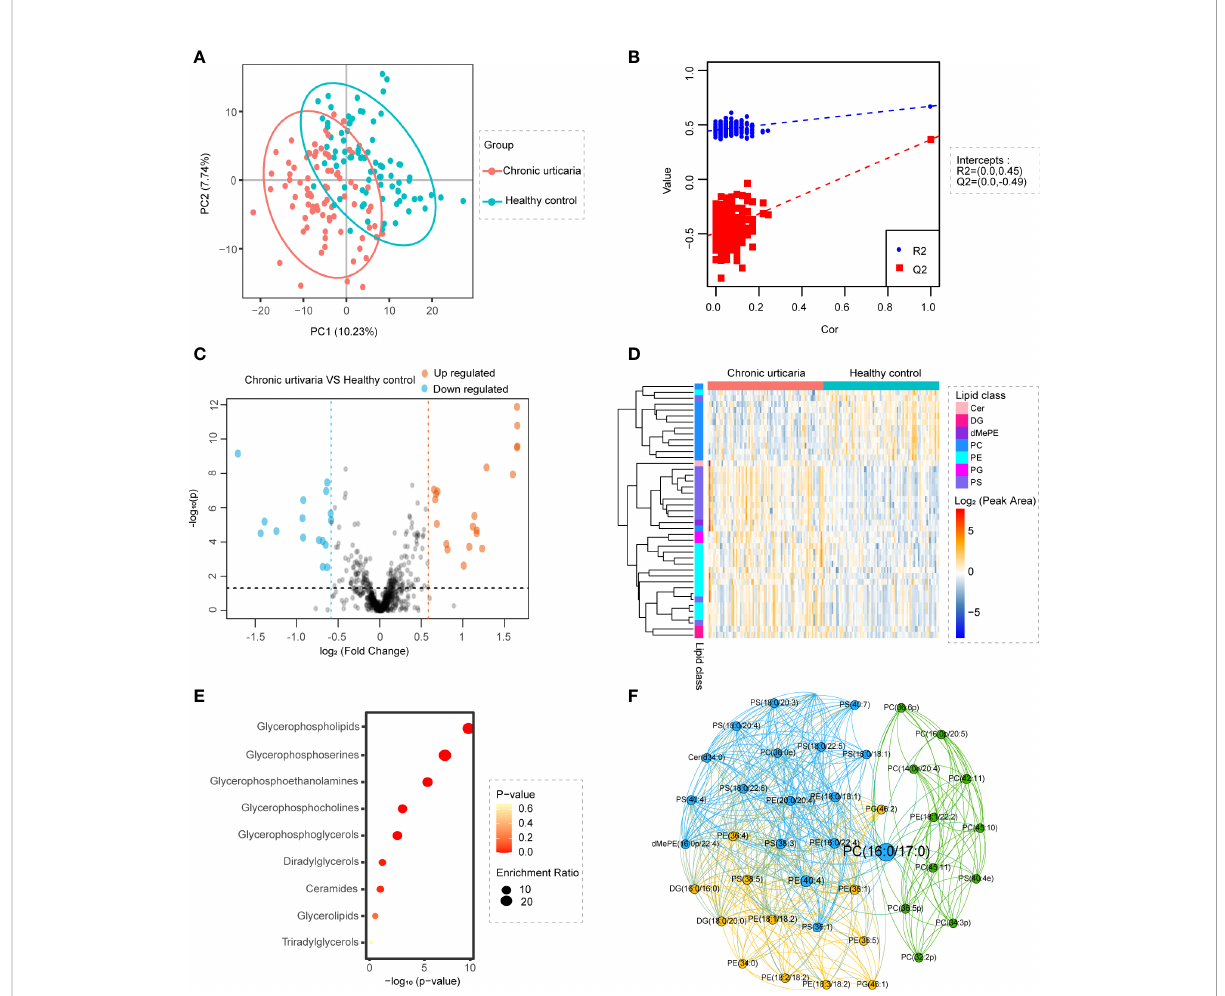
FIGURE 1 Identi fi cation of lipid pro fi ling in plasma of CU. (A) PLS-DA score plots show discrimination between the HC (blue) and CU (red). (B) Validation plots were obtained from 200 permutation tests (R2 = 0.672, Q2 = 0.365). (C) Volcano map of differentially expressed lipids between CU and HC groups. Blue represents the down-regulated lipid molecules, orange represents the up-regulated lipid, and non-signi fi cant lipid molecules are gray. Molecules, solid and round represent the lipid molecules VIP ≥ 1, hollow and round represents the lipid molecules VIP < 1. (D) Heatmap of the top 7 differentially lipids between HC and CU. Each row in the fi gure represents a differential lipid, and each column represents a sample. Different colors indicate different intensities, and colors range from blue to red, indicating strength from low to high. (E) Lipid metabolites set enrichment analysis for CU. Redder colors represent lower P values, and larger circles represent higher enrichment ratios. Low P-value and large enrichment ratio indicate that this pathway is enriched more. (F) The correlation analysis of different lipids showed that the same lipids had a good